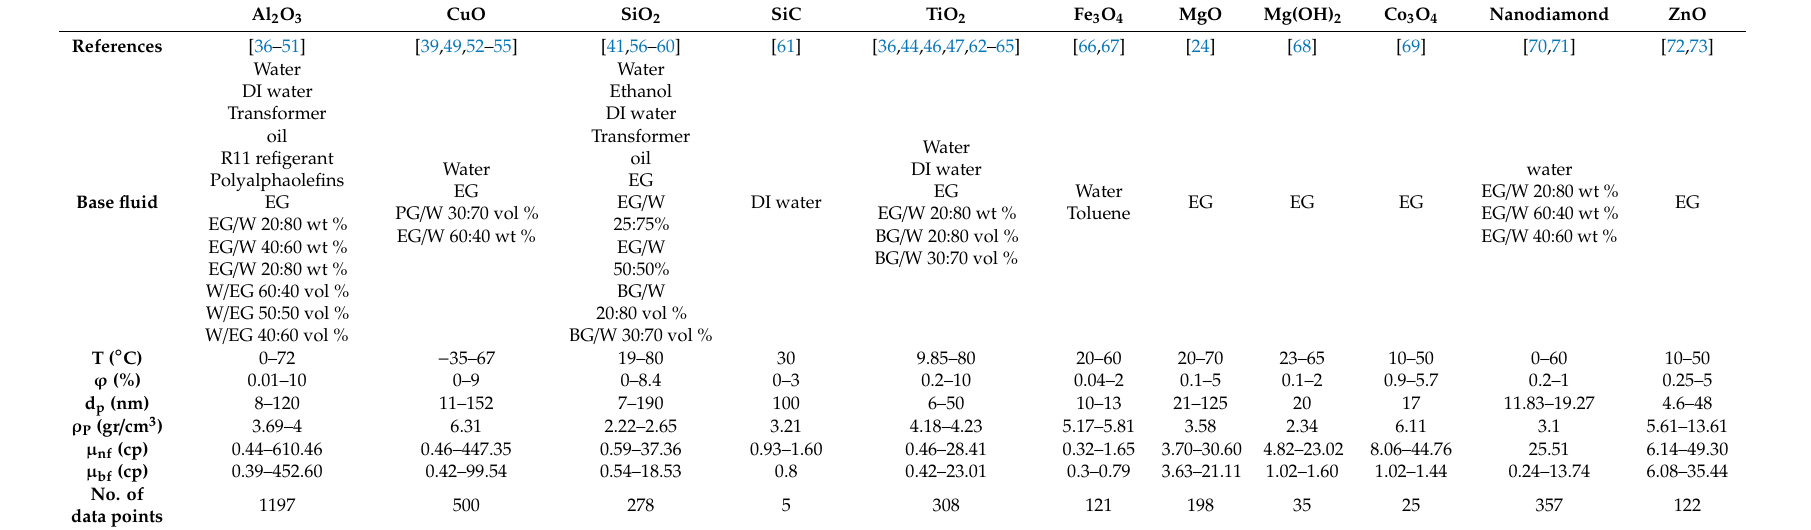
Table 1. The data bank of nanofluids used in this